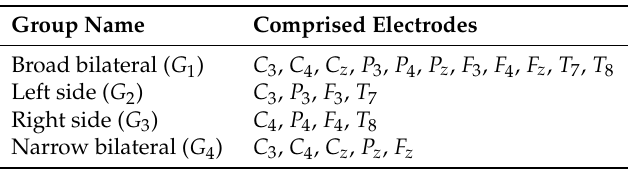
Table 2. The groups of electrodes analyzed in this